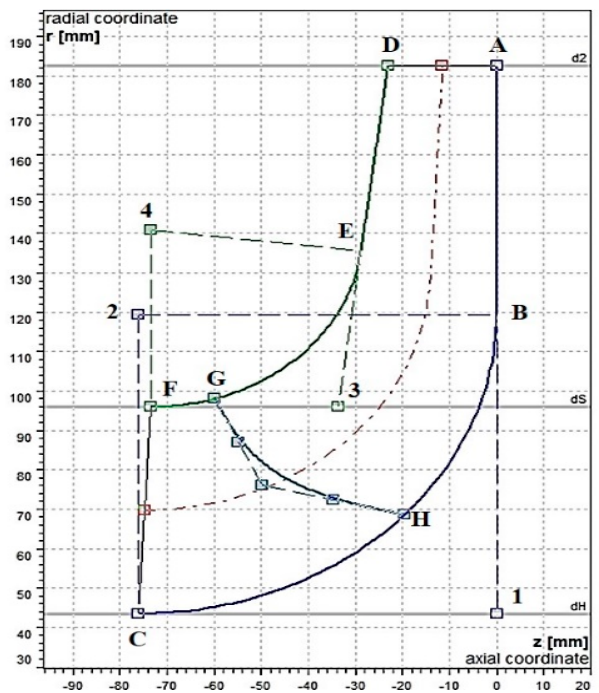
Figure 7. Meridional shape of impeller and leading edge of blade.